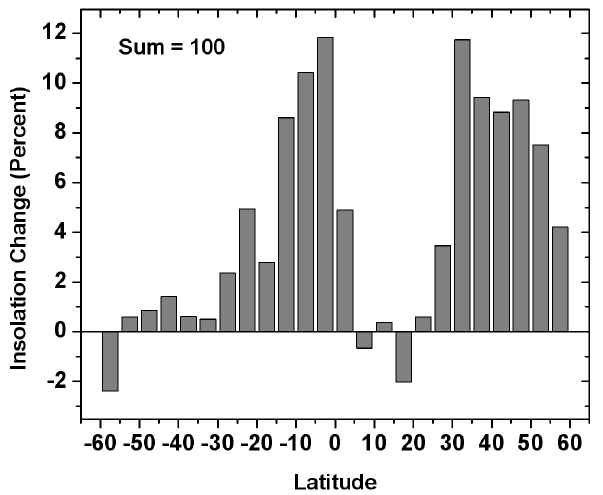
Fig. 13. Contour plot of latitude × longitude trends showing ma- jor areas of change inRUdecade − 1 based on the LER non-noon- normalized trend data in Fig. 11a (upper panel 1 ). LER trends smaller than | 0.3 | RUdecade − 1 are not statistically significant from zero. The area-averaging contour plot shows trend details that are not obvious in panels 1 and 2 of Fig. 11a. The LER trend numbers on the map refer to contour boundaries and not the colored areas represented by the